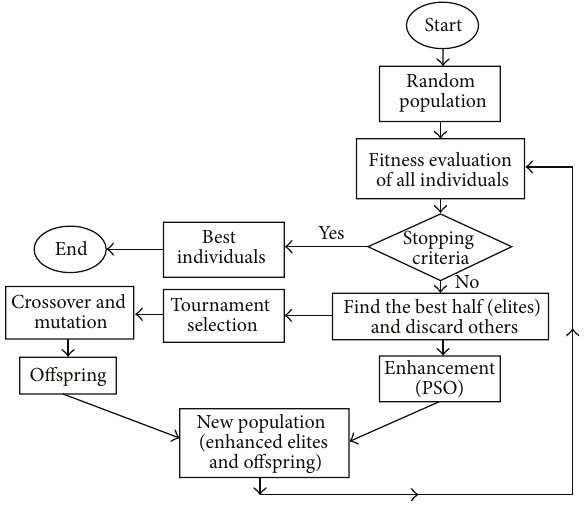
Figure 2: The block diagram of the HGAPSO